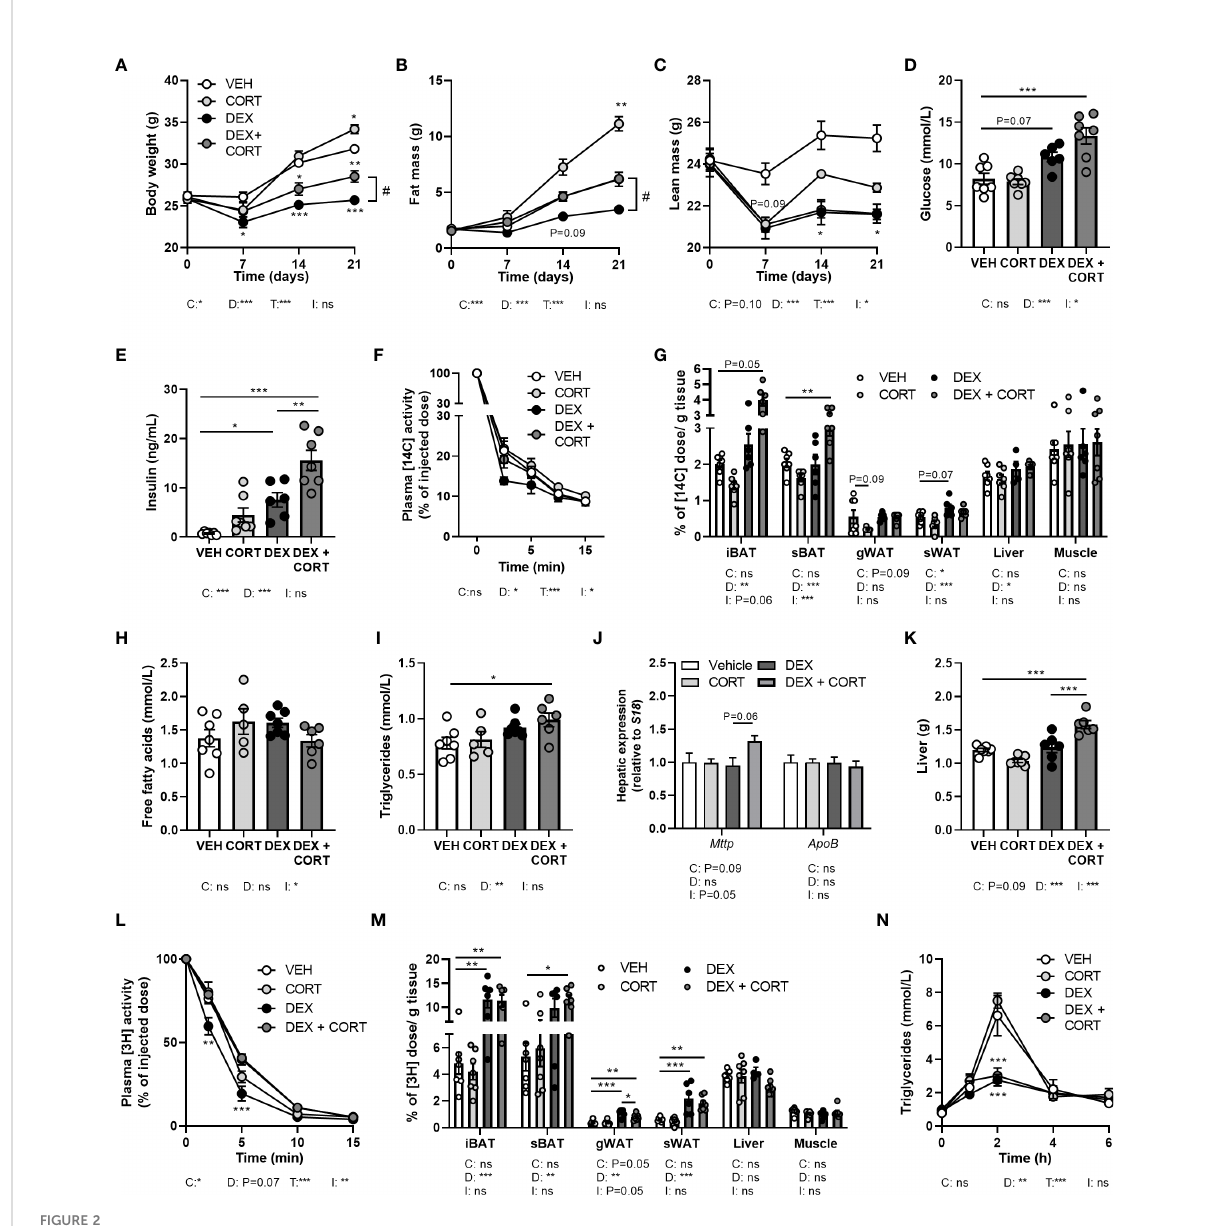
FIGURE 2 Corticosterone add-on treatment reverses dexamethasone-induced fat mass loss. Mice received a high-fat diet mixed with dexamethasone (DEX) or vehicle (VEH) and were subcutaneously implanted with low-dose (5 mg) corticosterone (CORT) or vehicle pellets for 3.5 weeks. (A – C) DEX decreased body weight, fat and lean mass, while DEX + CORT prevented the effects on body weight and fat mass. Asterisks show results of post-hoc comparisons with VEH, hash marks of post-hoc comparisons with the DEX. (D, E) DEX increased 6 h-fasted glucose and insulin levels after 23 days, while DEX + CORT aggravated this effect. (F) At AM, DEX induced a more rapid plasma clearance of intravenously injected [ 14 C]-deoxyglucose, which was prevented by DEX + CORT. (G) DEX + CORT increased [ 14 C]-deoxyglucose uptake in interscapular brown adipose tissue (BAT). (H) 4 h-fasted plasma free fatty acid levels were unaffected in all treatment groups. (I, J) DEX + CORT increased 4 h-fasted plasma triglyceride levels and hepatic expression of Mttp but not Apob . (K) DEX + CORT increased liver weight. (L) DEX induced a more rapid plasma clearance of intravenously injected triglyceride-rich lipoprotein-like particles containing glycerol tri[ 3 H]oleate. (M) DEX and DEX + CORT similarly increased the uptake [ 3 H]oleate in BAT and white adipose tissue (WAT) depots. (N) Upon an oral lipid bolus, DEX strongly reduced peak plasma triglyceride levels. Statistical signi fi cance was calculated using 2-way ANOVA analysis in (D, E, G – K, M) ; with 3-way ANOVA analysis in (F, L) ; with linear mixed models in (A – C, N) . Depicted below the graphs are the P-values of the ANOVA tests for either time (T), CORT (C), DEX (D) or the interaction between CORT and DEX (I). *P < 0.05, ** P < 0.01, ***P < 0.001. 'ns' means 'not signi fi